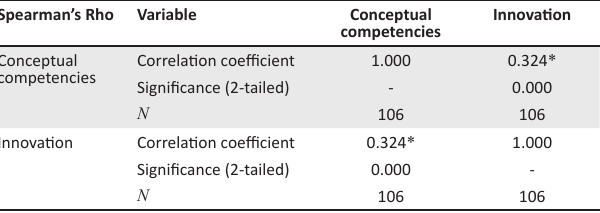
TABLE 5 : Spearman’s correlation on managerial conceptual competencies versus innovation. Spearman’s Rho Variable